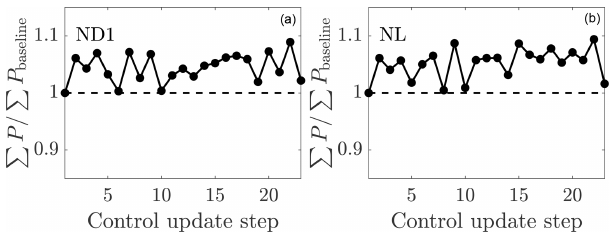
Figure 9. Time-averaged wind farm power production as a function of the control update steps for (a) online control using the initial pa- rameters to initialize the next state (ND1) and (b) the lookup table control (NL). The wind farm power is normalized by the power pro- duction of the aligned wind farm case.